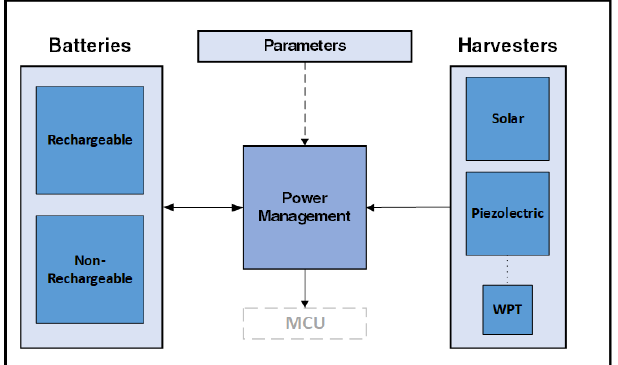
Figure 2. Abstract schematic of the mote’s energy module. Power management submodule has dual input (harvesters and batteries) single output and accepts parameters for its operation. 1. The energy reservoir that retains the energy collected for prospective use. 2. The energy harvesters that collect ambient